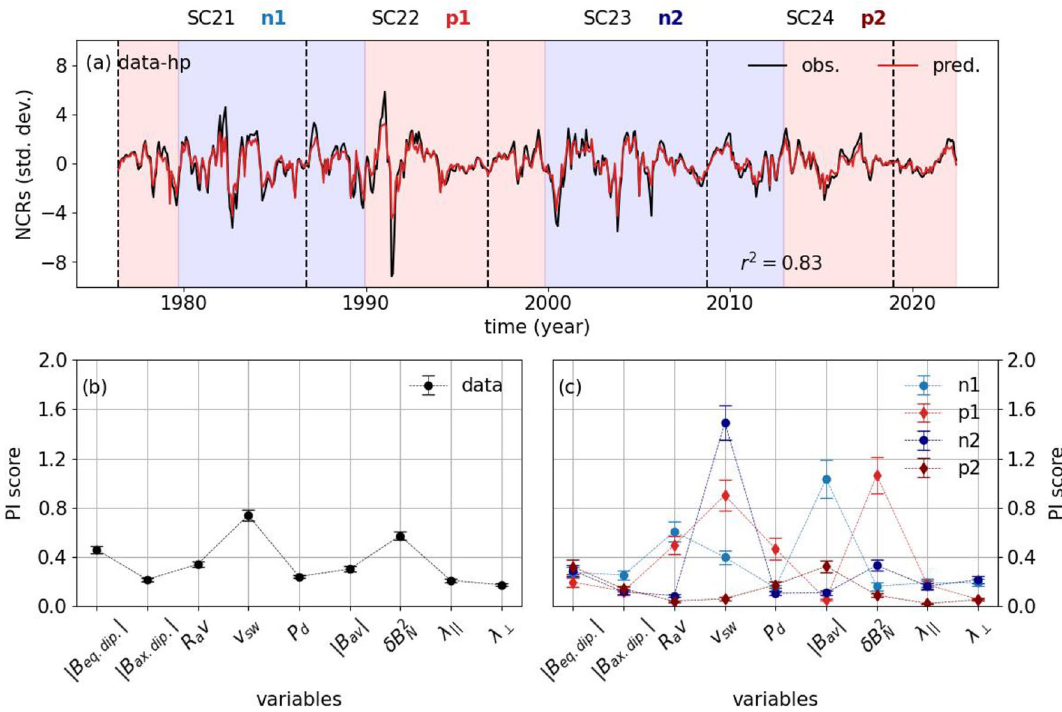
Figure 4. Same as Fig. 2, but for the high-pass filtered